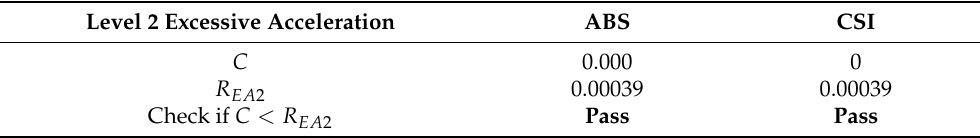
Table 8. Level 2 assessment of the excessive acceleration failure mode for barge.